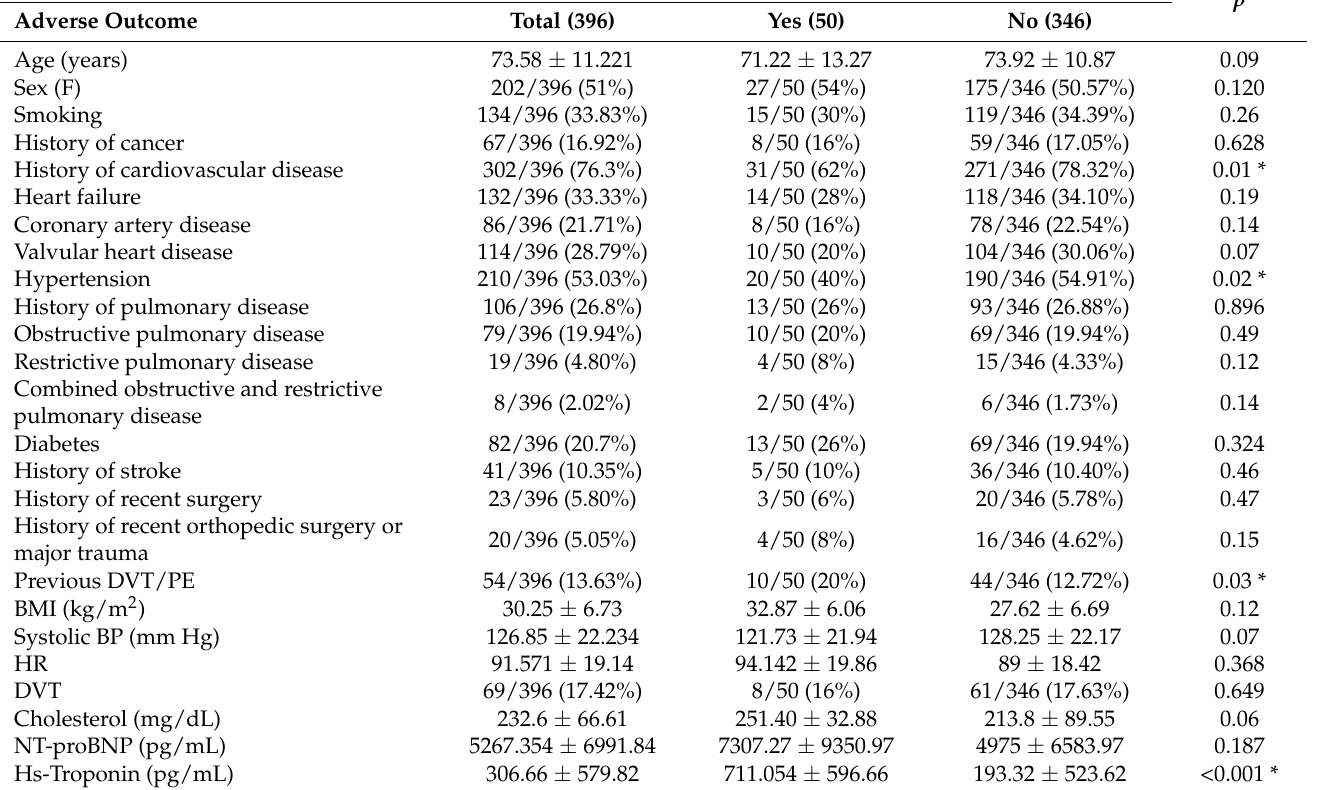
Table 1. Comparative baseline demographic, clinical and laboratory parameters in patients with and without in hospital adverse